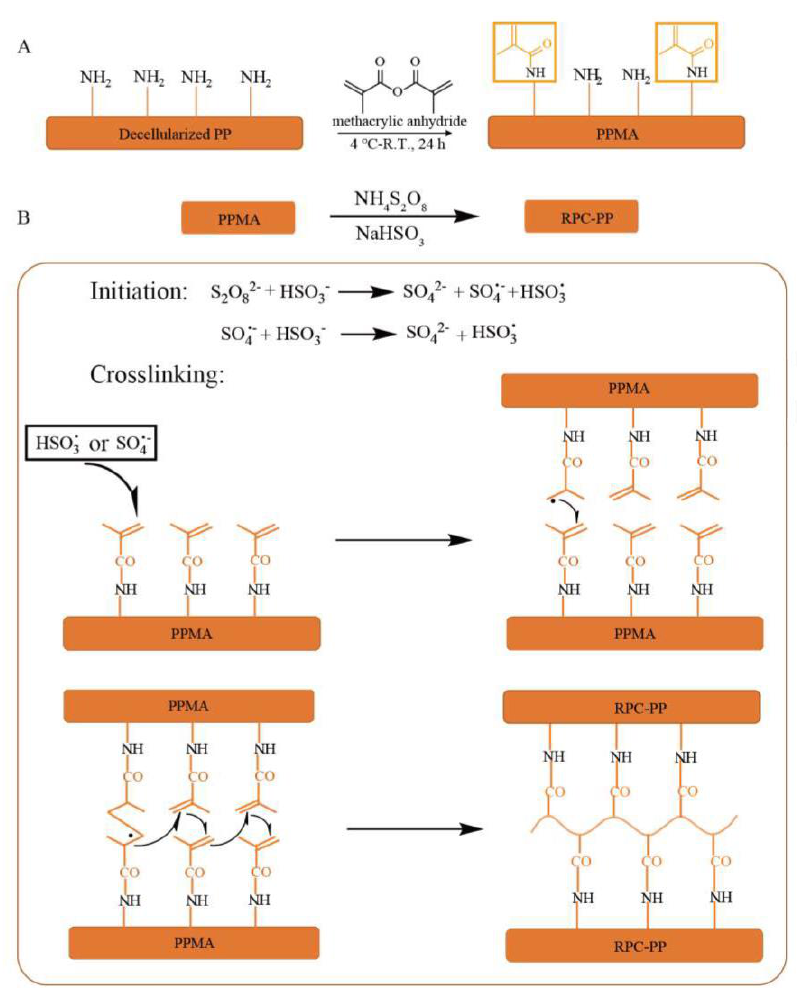
Figure 2. Schematic illustrations of the presumable cross-linking mechanism for RPC-PP. ( A ) Syn- thesis of PPMA. ( B ) Cross-linking of PPMA. PP, porcine pericardium; PPMA, porcine pericardium methacryloyl; RPC-PP, radical polymerization cross-linking-treated PP (adapted from Ref. [44]).